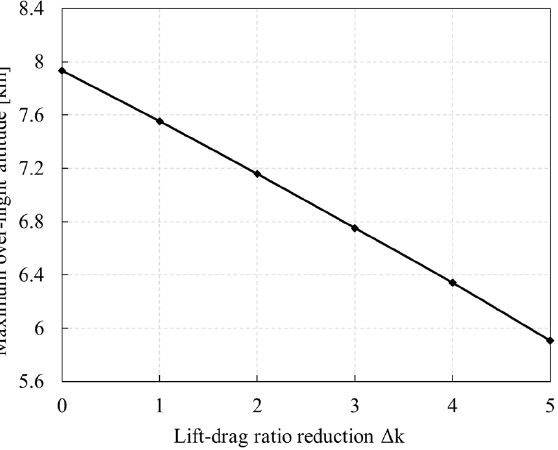
Figure 35. Influence of lift–drag ratio reduction on maximum overnight altitude (Mar. 21, 41° N).